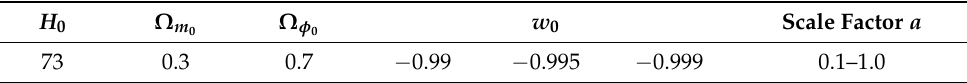
Table 1. Boundary conditions and parameter values in this work. H 0 is the current value of the Hubble parameter in units of km / sec . Ω m and Ω φ are the current ratios of the matter and dark energy Mpc 0 0 densities to the critical density. w 0 are the current values of the dark energy equation of state. Ω H 0 Ω m φ 0 w 0 Scale Factor 0